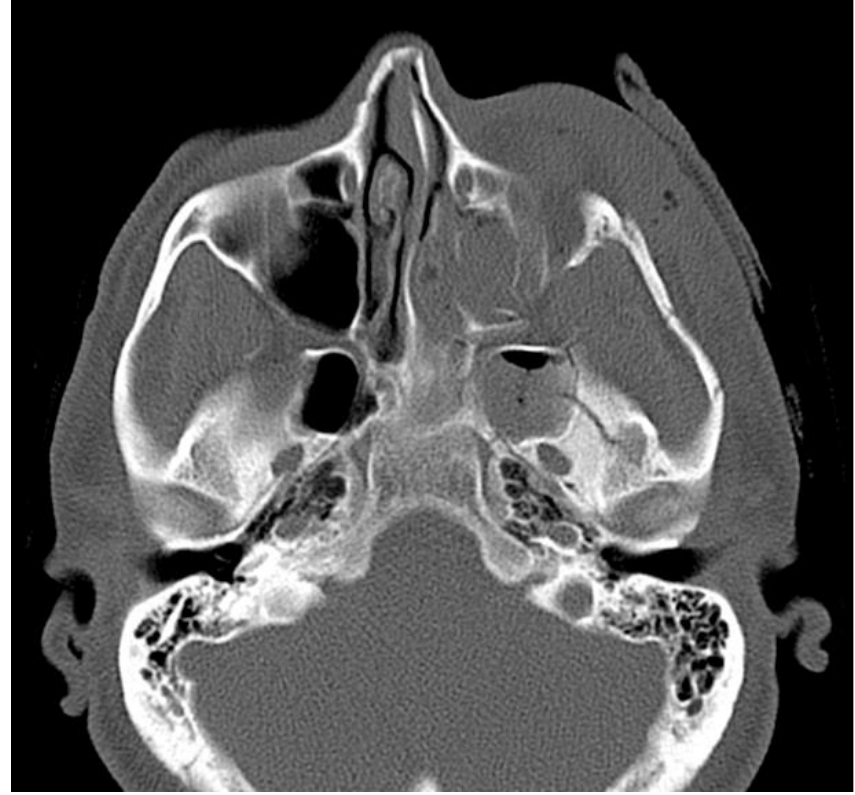
Figure 7. Middle cranial vault and skull base fracture.